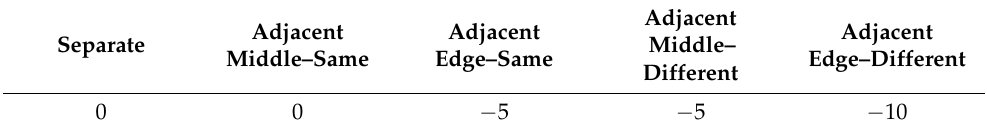
Table 12. Negativity scores of building order and floor level